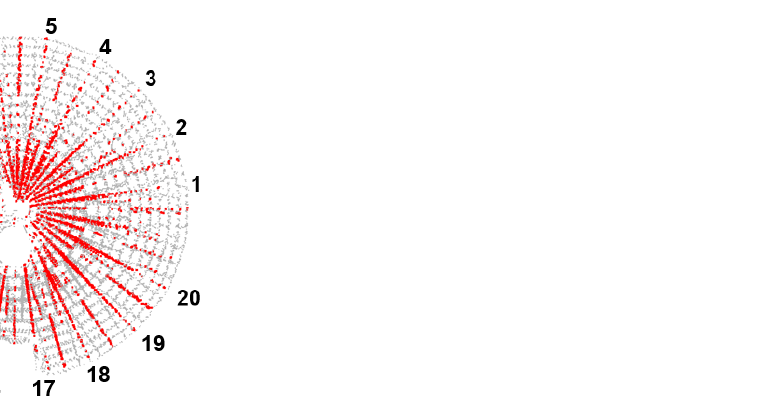
( c ) Figure 41. Extracted edge points from the scans in the West Lafayette dataset before/after the full fine registration: ( a ) partial fine registered edge points, ( b ) full fine registered edge points using roof/stringer features, and ( c ) full fine registered edge points using the roof/stringer/ground/wall fea- tures. The initial/final RMS of the fitting errors for the roof/stringer and roof/stringer/ground/wall features are presented in Table 6. While a total of 69 stringers were detected/used for the full fine registration process, the fitting errors for only 20 stringers are listed in Table 6 (refer to Figure 42). In general, the fitting quality for the stringers has improved after the full fine registration for both feature combinations, while showing sim- ilar improvement magnitude. Some abnormally high fitting errors can be seen in Table 6 (shown in red). The large fitting errors for these stringers are mainly caused by some out- liers. As can be seen in Figure 42, the stringer features in the West Lafayette dataset are much closer to each other, with an average angular separation of ~3 ° , than those for the Lebanon dataset. In spite of some outliers, the large number of inlier stringers would still ensure the alignment quality of the final point cloud. The reported values for the ground/wall features in Table 6 show good feature alignments in both full fine registration results, while the second combination provide better alignment (this is expected due to the explicit use of such features in the full fine registration). Finally, a volume estimation is conducted using the derived point clouds from the two feature combinations. The cal- culated volumes for the roof/stringer and roof/stringer/ground/wall feature combinations are